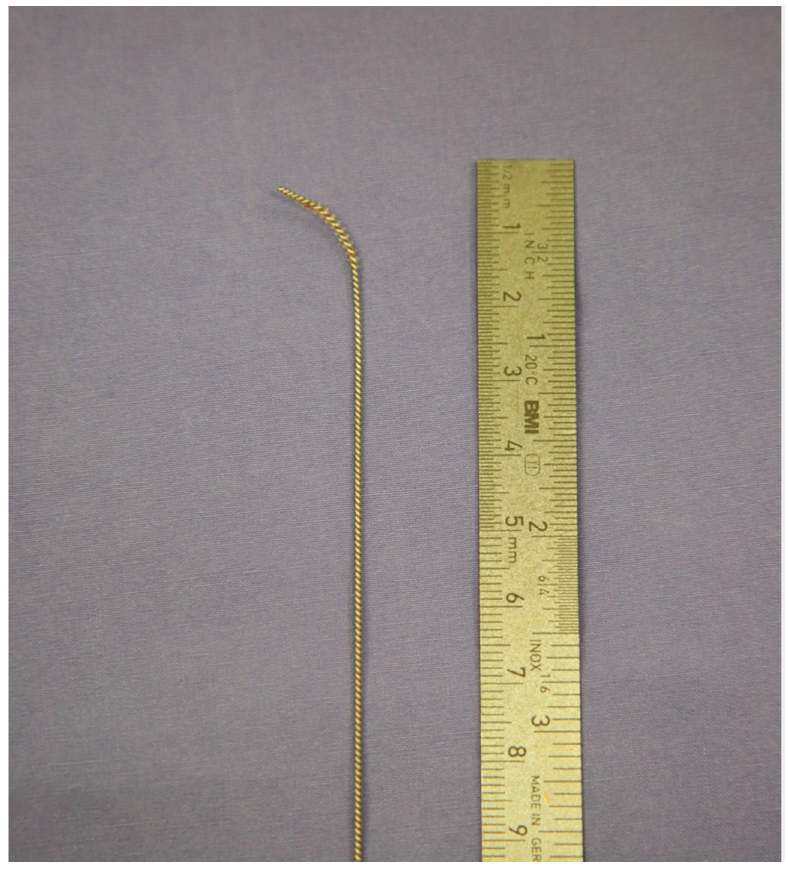
Figure 3. The stylet bent at an angle with a ruler next to it for comparison.